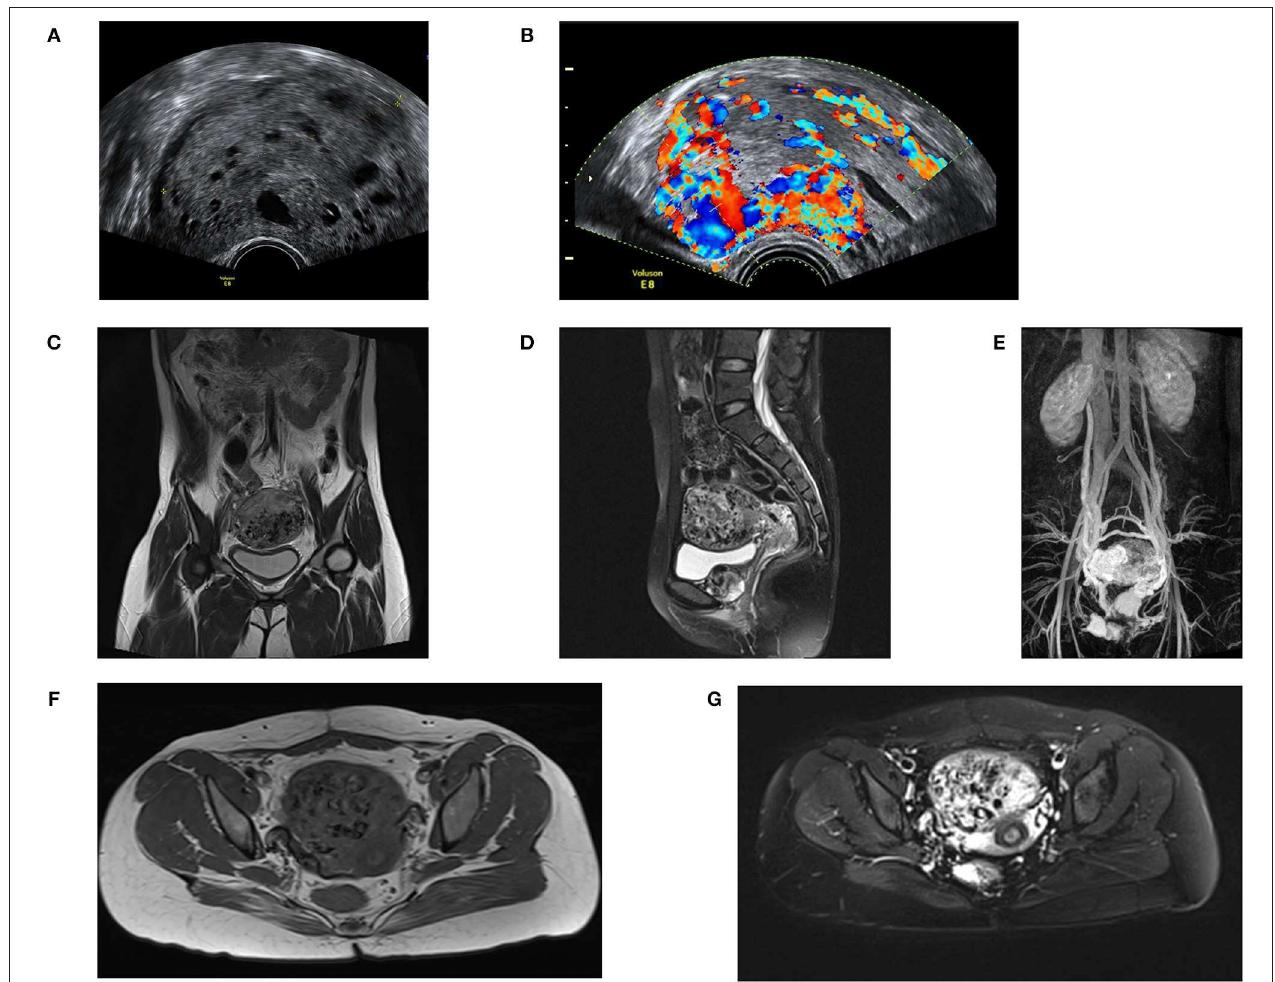
FIGURE 4 | Imaging features of PSTT. (A) Ultrasound feature of PSTT: the mass shows as a mixed mass with intact capsule and presents as echogenic bulk. (B) Ultrasound feature of PSTT: formation of arteriovenous fistula can be observed. (C,D) MRI imaging of sagittal position: PSTT presents as uterine dilatation with short T1 and long T2 signals. (E,F) MRI imaging of axial position. (G) Enhancement imaging: the parauterine artery can be